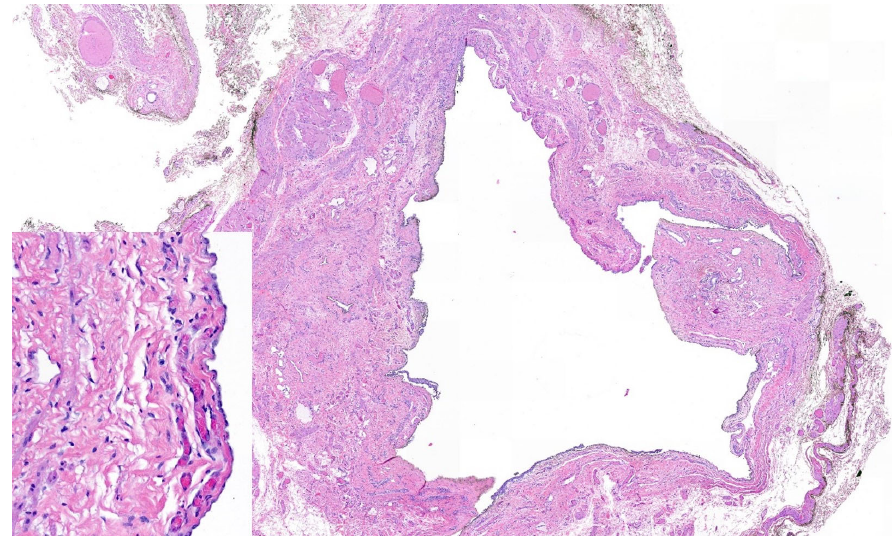
Figure 3. Histology hematoxylin and eosin staining: cystic structure localized within fibromuscular and adipose tissue demonstrating a flat to cuboidal mesothelial lining (left corner), consistent with a hydrocele of the canal of Nuck.